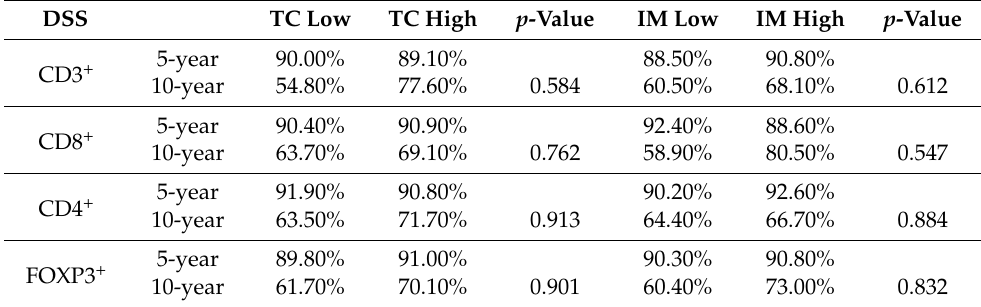
Table 4. Disease specific-survival (DSS) rates according to dichotomized (based on median values) CD3 + , CD8 + , CD4 + and FOXP3 + T cell densities at the tumor center (TC) and at the invasive margin (IM) in primary small bowel neuroendocrine tumors. DSS TC Low TC High p -Value